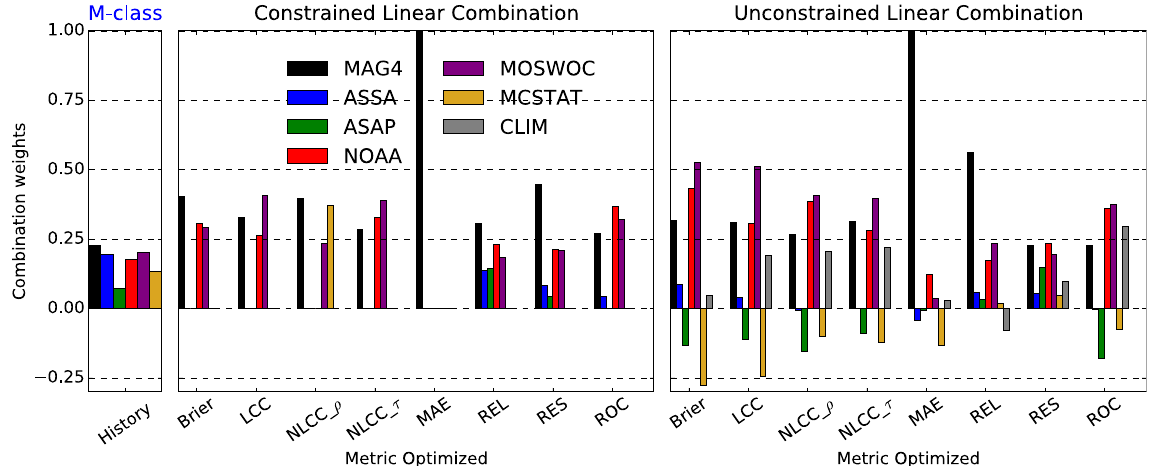
Fig. 3. Ensemble combination weights for the optimization of probabilistic metrics (Table 3, left column) on M-class fl are forecasts. Left panel corresponds to combination weights calculated from performance track (see text for details) while middle and right panels correspond to constrained and unconstrained linear combinations, respectively. Weights are presented using the same color scheme as Figure 2 for each forecast method member. Note, ULC weights corresponding to the climatological forecast member are displayed in gray in the right